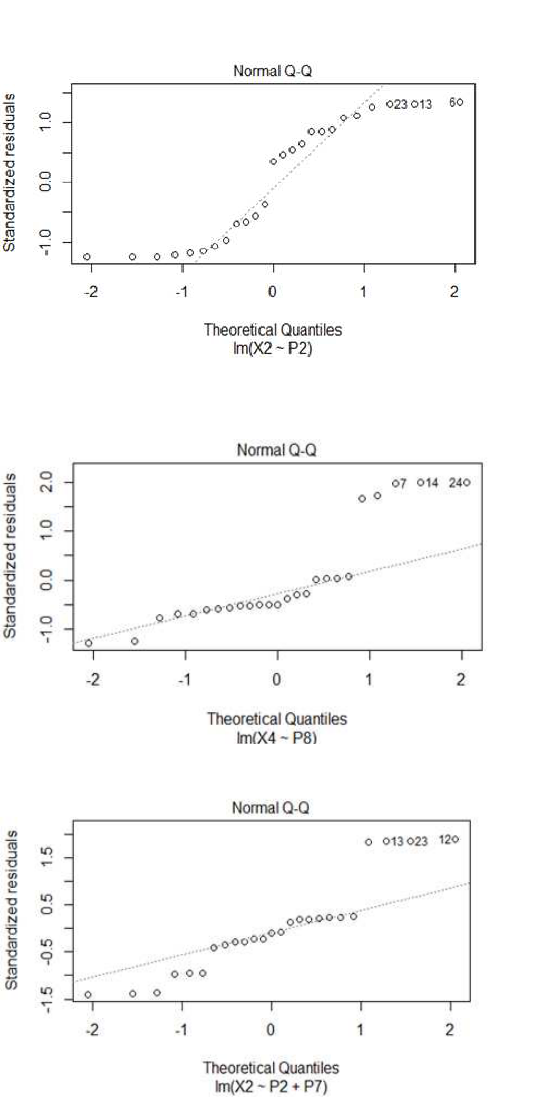
Figure 2. Q-Q plots for X